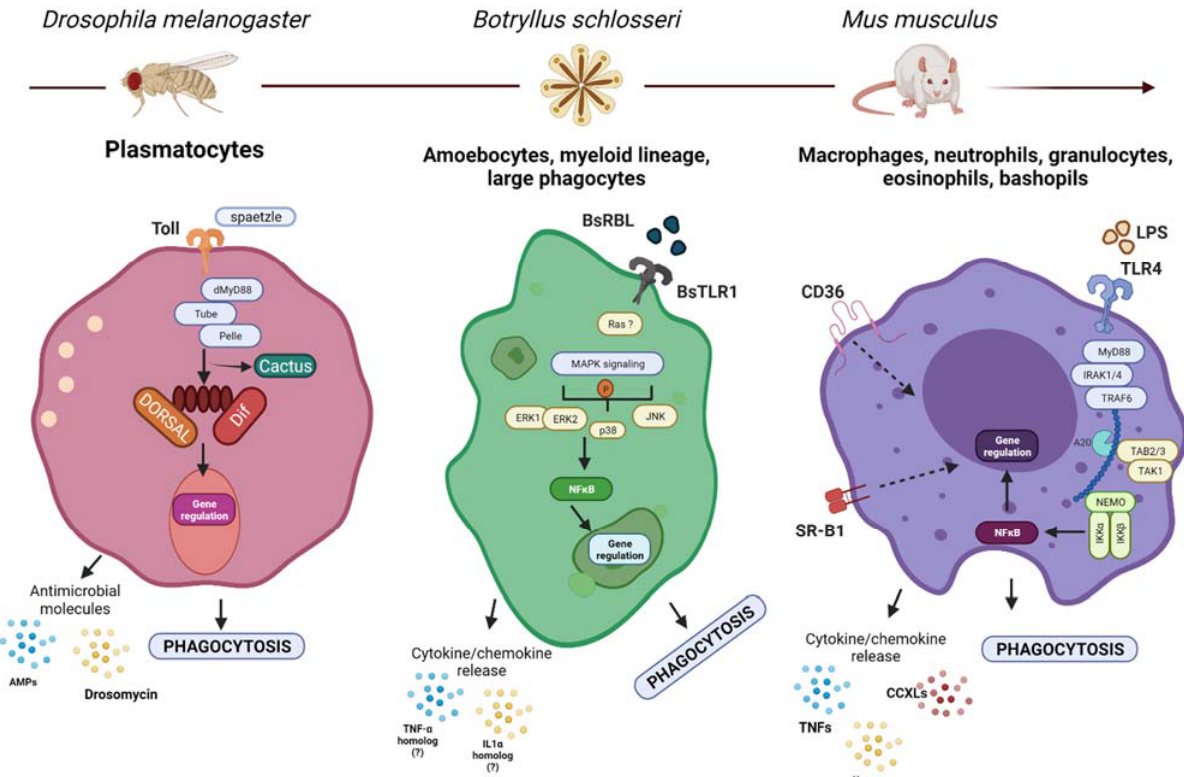
Figure 1. Molecular mechanisms guiding phagocytosis in different organisms. Although the phagocytic lineages and their molecular mechanisms guiding the process of phagocytosis could be different, they share several basic mechanisms with their ancestral form. Shown here: ( left ) the Toll pathway in Drosophila is activated by spaetzle, leading to an intracellular signaling that results in the degradation of cactus and the concomitant release of DIF/DORSAL which translocate to the nucleus and activate the transcription of immune genes including AMPs and drosomycin, which secreted as a response to infection [46]. ( center ) BsTLR1, Ras, MAPK, NF κ B and cytokine homologs have been associated with the modulation of phagocytosis in B. Schlosseri. (?)—Represents missing functional or molecular validation. Similarly ( right ), mammalian TLRs are activated by microbial- and self-derived products leading to the activation of intracellular signaling cascade that results in the translocation of NF κ B to the nucleus to activate the transcription of different cytokines and chemokines which enhance the phagocytic activity of the cells [47]. Created with BioRender.com.